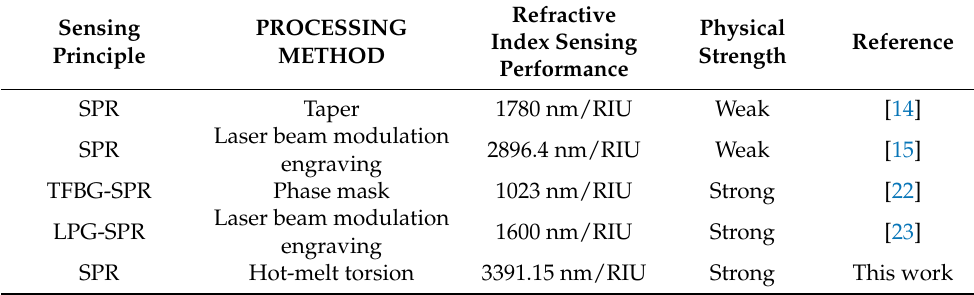
Table 1. Performance comparison of different cladding SPR